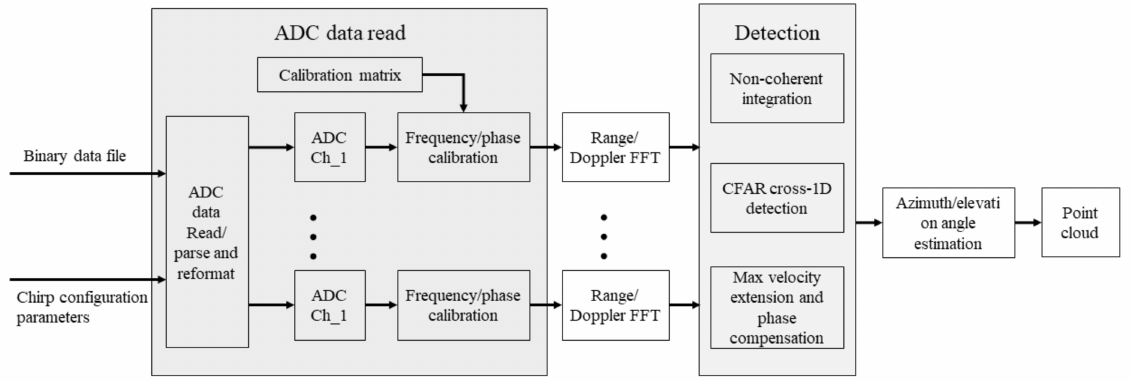
Figure 6. The radar signal processing